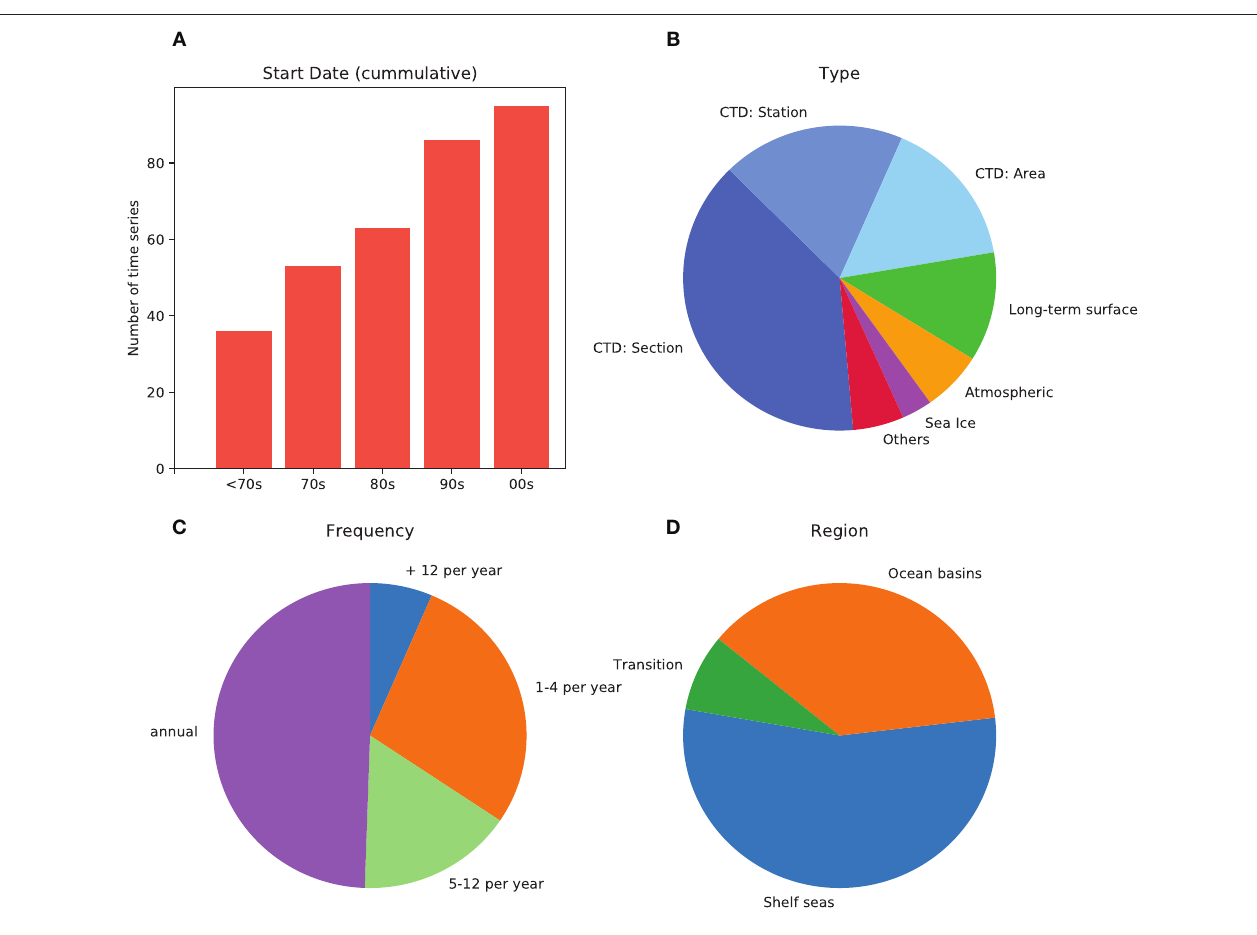
FIGURE 2 | Basic properties of timeseries included in the IROC. The report currently includes 95 timeseries from 76 locations, provided by 32 organizations across 15 countries. (A) Histogram of the starting dates of the timeseries grouped by decade (cummulative), (B) timeseries type: where “others” accounts for modeled flow, heat content anomaly, fresh water anomaly and spatial extent of specific water masses (i.e., the Cold Intermediate Level), (C) timeseries sampling frequency, (D) oceanic region, where ‘Transition’ includes stations over continental slopes and within